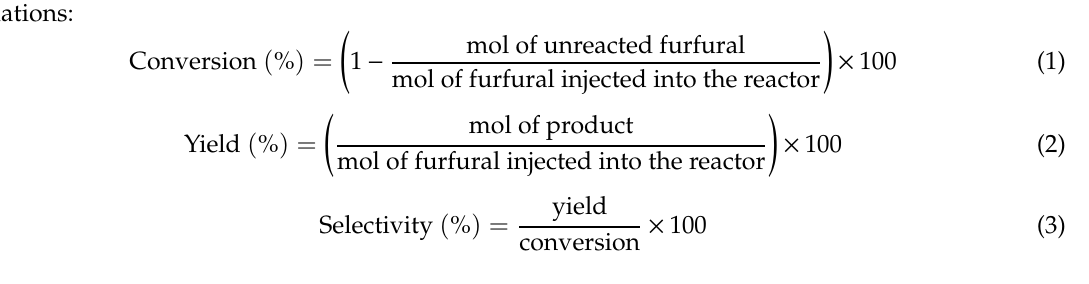
Figure S1: N 2 sorption isotherms of Pt catalysts on di ff erent supports. Figure S2: XRD patterns of 1%Pt / SBA-15, 1%Pt / MFI(NS) and 1%Pt / DeAl-Hbeta catalysts. Figure S3: Small-angle X-ray scattering patterns of SBA-15 and Pt / SBA-15. Figure S4: SEM images of (A) 1%Pt / SBA-15, (B) 1%Pt / MFI(NS) and (C) 1%Pt / DeAl-Hbeta. Figure S5: Pyridine-IR spectra of (A) 1%Pt / SBA-15, (B) 1%Pt / MFI(NS) and (C) 1%Pt / DeAl-Hbeta catalysts desorbed at 423, 523 and 623 K. Figure S6: CO-FTIR spectra of 1%Pt / SBA-15 catalysts prepared under di ff erent conditions. Figure S7: (A) Furfural conversion and (B) furan selectivity as a function of time on stream. Table S1: Specific surface areas and pore structures of the silica supports and Pt catalysts. Table S2: Metallic Pt dispersion and nanoparticle size of Pt determined by CO-pulse adsorption. Table S3: Numbers of acid sites on di ff erent silica-supported Pt catalysts. Table S4: Catalytic performance of the various